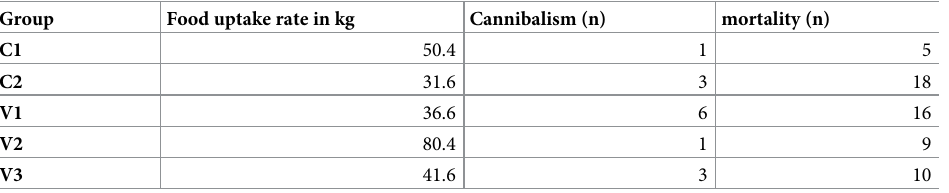
Table 1. Food uptake rate in kilograms, cannibalism and died chicken, split in groups.